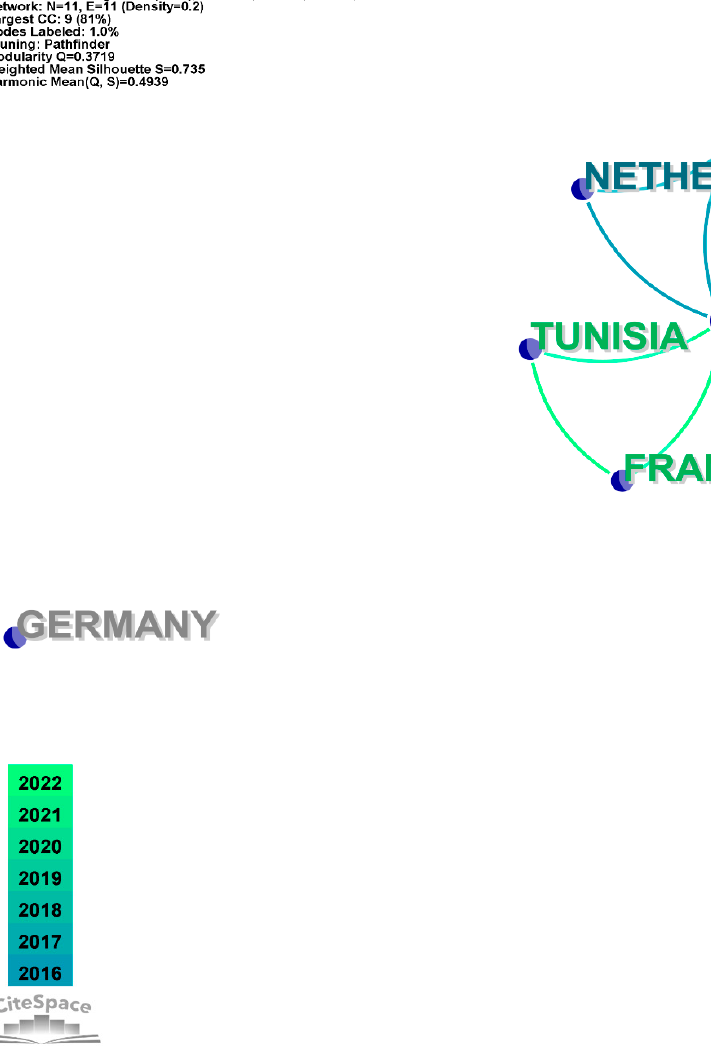
Figure 2. Distribution of the number of records attributed to authors based in each country.